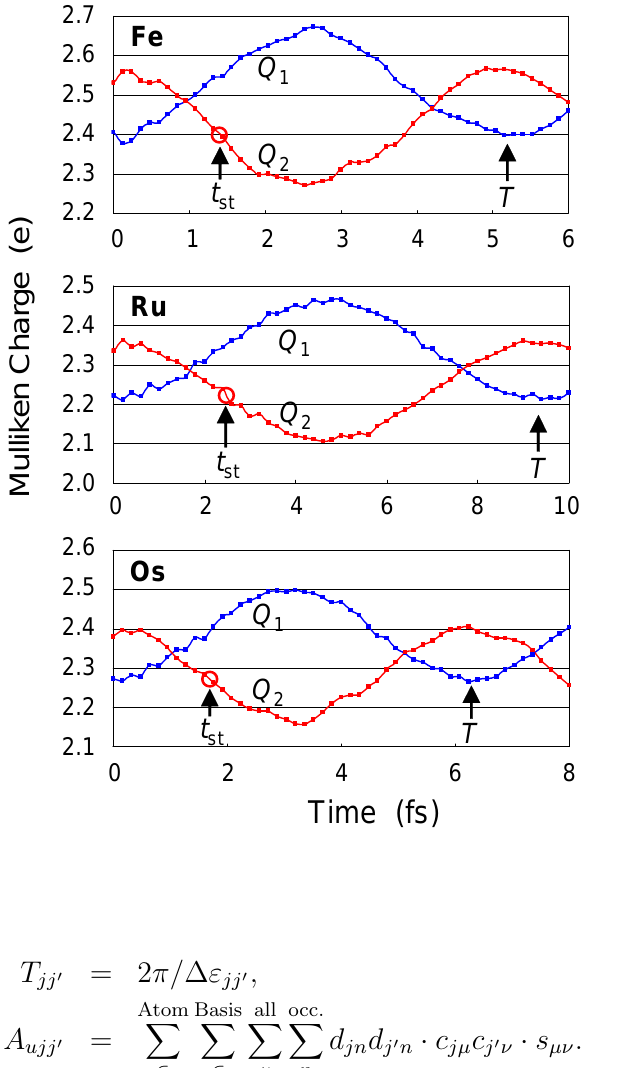
Figure 7. Dynamic behaviors of bpy complex upon the switch of input ( q = +0 . 5 e → q = − 0 . 5